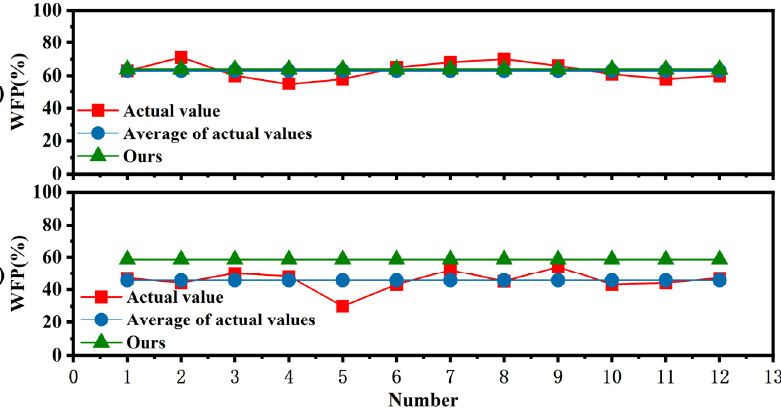
Figure 15. Stability analysis of both methods. ( a ) Time for 12 testers to measure the same sample; ( b ) One experimenter measures the time variation of 12 specimens. ( b ) One experimenter measures the time variation of 12